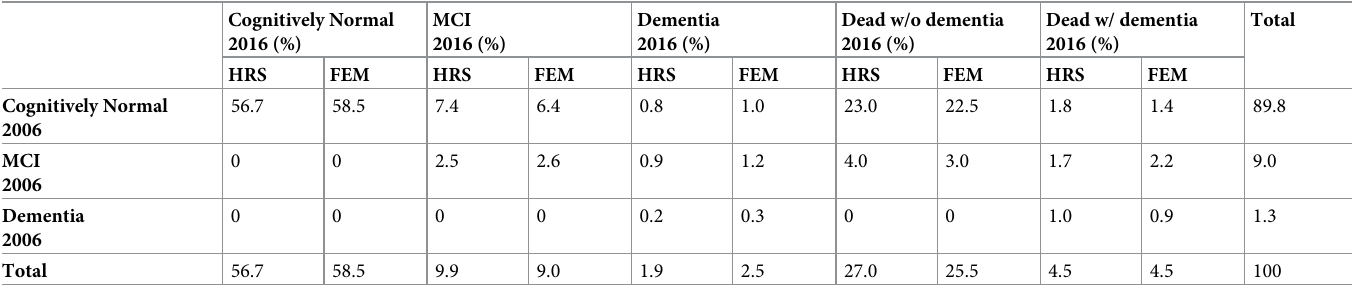
Table 4. 10-year change in distributions of cognitive status based on TICS score, HRS and